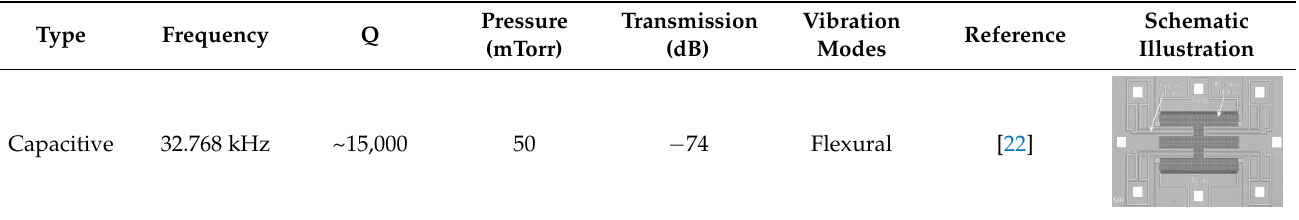
Table 2. Summary of representative different modes resonators in specific applications.